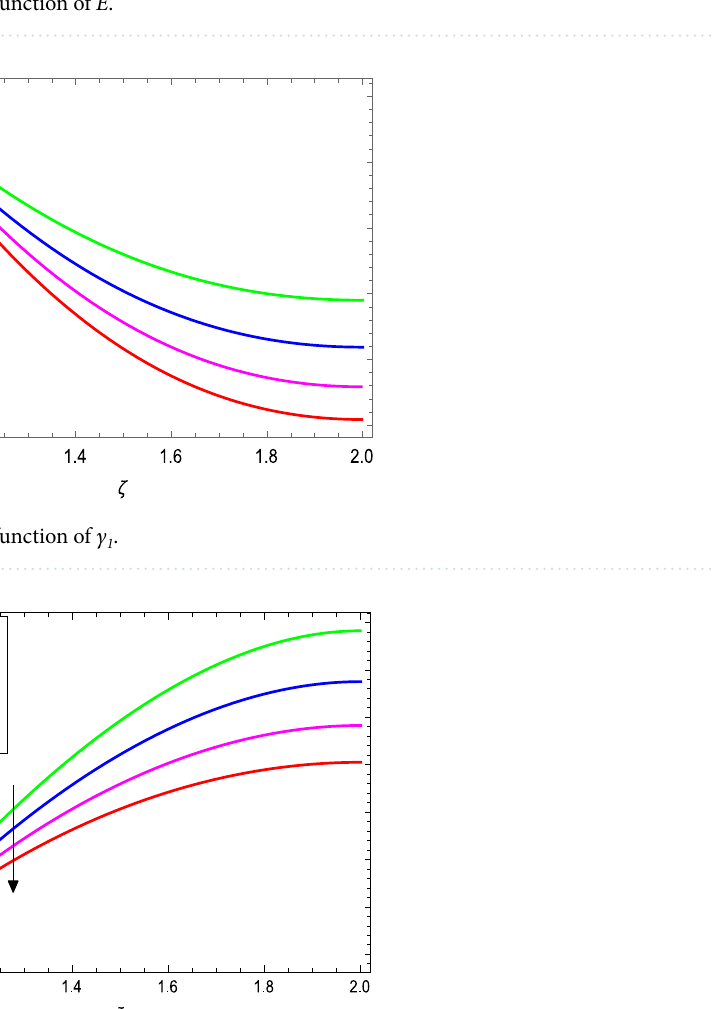
(ζ) as a function of Sc ϕ